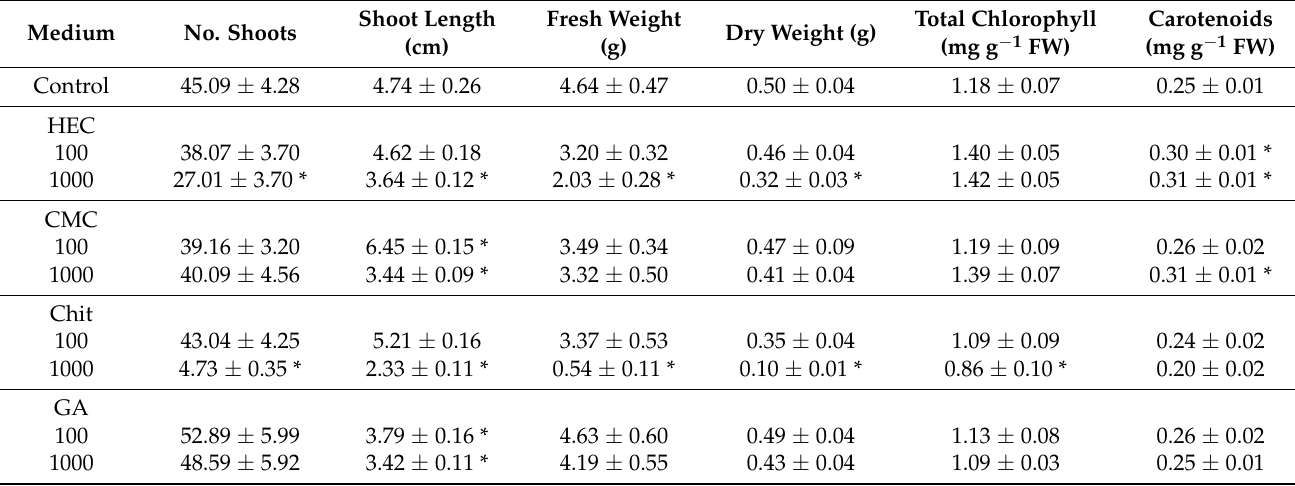
Values are expressed as the mean ± SE. For each parameter, the asterisks (*) indicate differences from the control using Dunnett’s test at p < 0.05. HEC: hydroxyethyl cellulose; CMC: carboxymethylcellulose sodium salt; Chit: chitosan; GA: gum arabic; 100: 100 mg L − 1 ; 1000: